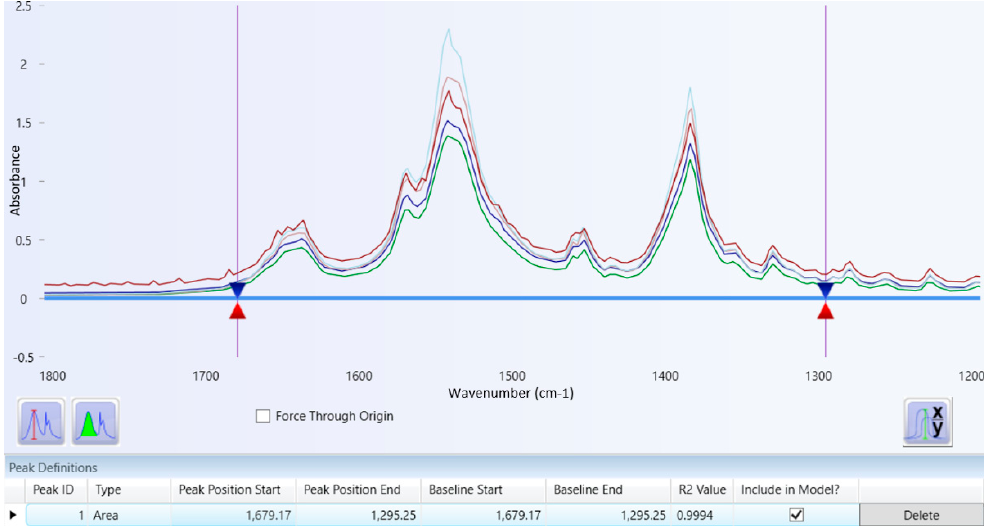
Figure 4. Overlay spectrum of regression data set series of tranexamic acid.